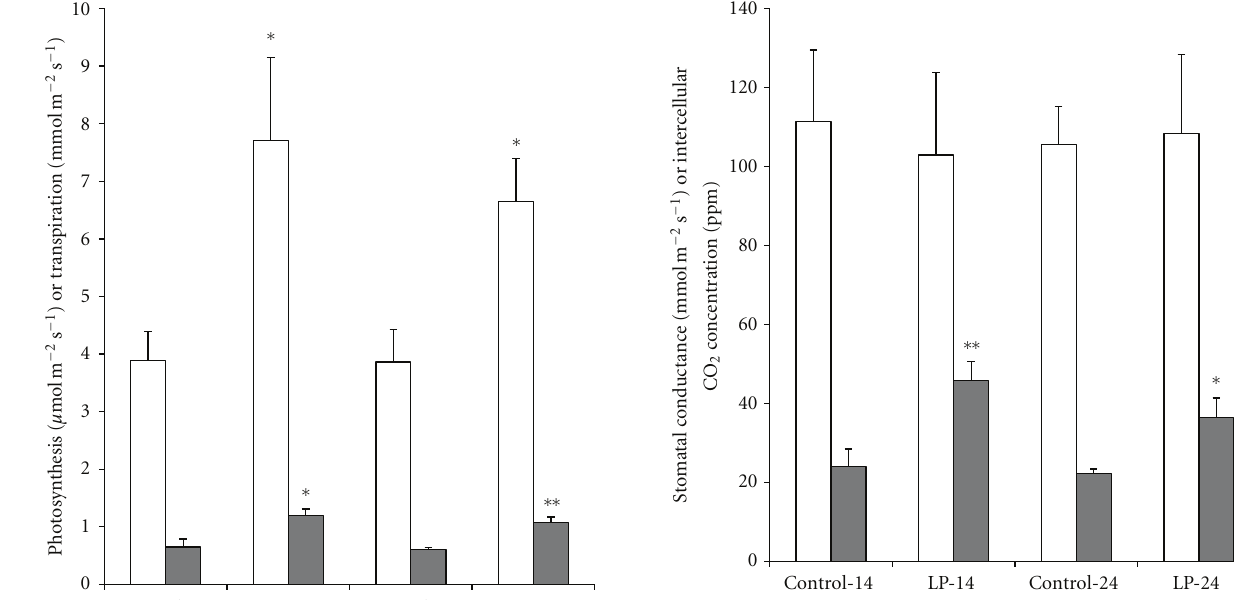
Figure 2: Leaf stomatal conductance and intercellular CO 2 con- centration in soybean plants grown with original pots (Control) and with larger pots (LP). Summary of growth conditions is described in Figure 1. Open bar, intercellular CO 2 concentration; closed bar, stomatal conductance. Vertical bars, S.D. ( n = 3). ∗ P < 0 . 05/ ∗∗ P < 0 . 01 ( t -test) when compared with